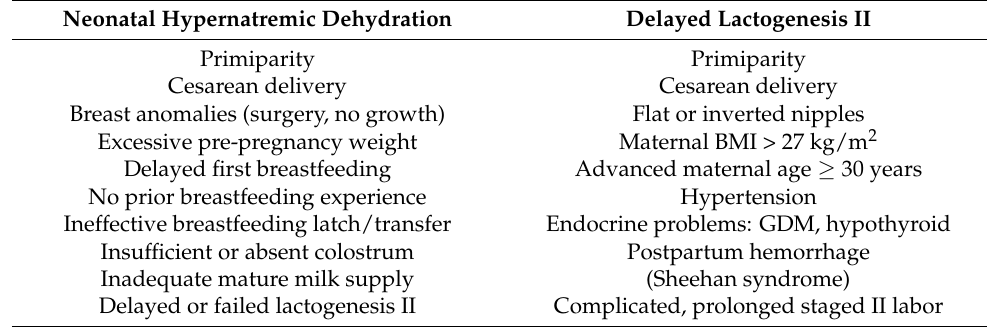
Table 2. Risk factors for neonatal hypernatremic dehydration and delayed lactogenesis II [16,25–31]. Neonatal Hypernatremic Dehydration Delayed Lactogenesis II Primiparity Primiparity Cesarean delivery Cesarean